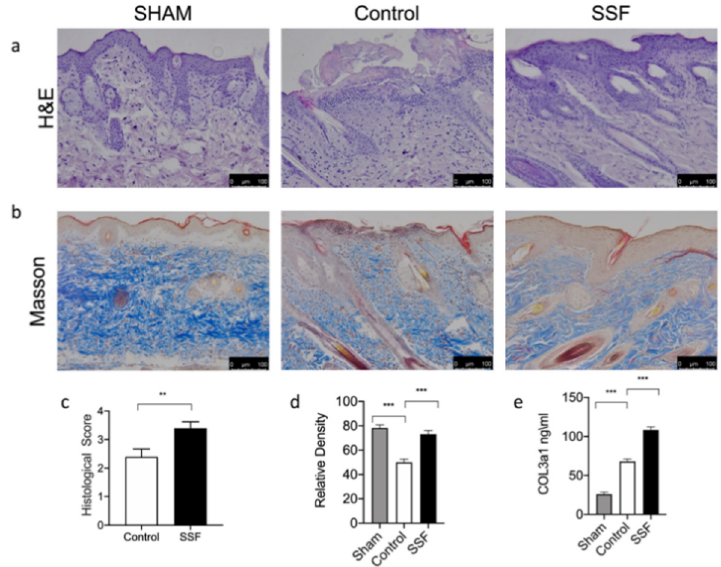
Figure 2. Effect of SSF on skin wound healing and collagen pattern in a mouse model of full-thickness excisional wound. ( a , c ) H&E staining of wound granulation tissue 14 days after wounding and relative histological score graph. ( b , d ) Evaluation of collagen deposition by Masson staining on day 14 after wounding and a relative density graph as a qualification of the stain intensity of blue collagen. ( e ) COL3a1 quantification by ELISA assay in wound tissue. Data are presented as means ± SEM images of 10 mice for each group. ** p < 0.01 *** p < 0.001.